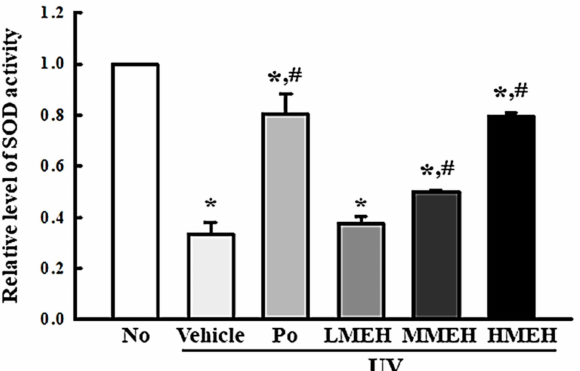
Figure 3. Determination of SOD activity in normal human dermal fibroblasts. One SOD unit is defined as the amount of the enzyme in the sample (20 µ L) that inhibits the reduction reaction of water-soluble tetrazolium salt-1 (WST-1) with superoxide anion by 50%. Three to five dishes per group were used to measure SOD activity, and the assay was repeated for three times. The SOD activity was analyzed in triplicate. Data are reported as the mean ± SD of triplicates. *, p < 0.05 compared with the untreated group. #, p < 0.05 compared with the UV + Vehicle group. Abbreviations: SOD, Superoxide dismutase; WST-1, Water-Soluble Tetrazolium 1; Po, Positive control; MEH, Methanol extract of Hygrophila erecta (Brum. F.) Hochr.